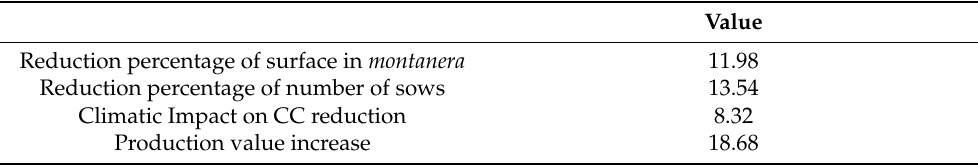
Table 5. Average percentage reduction of surface used in montanera, sows, climate change, and increase in production value.